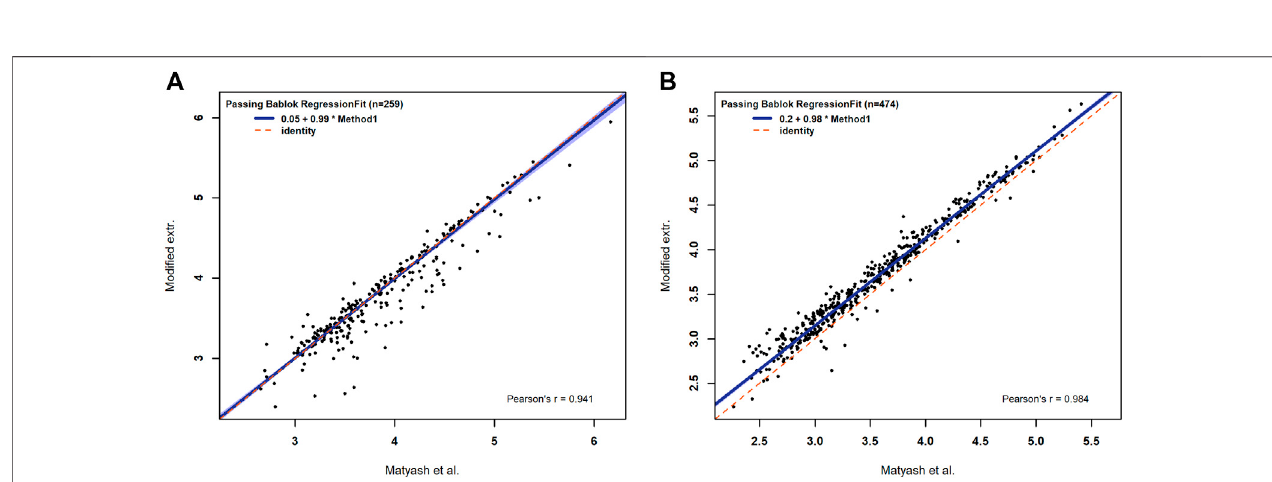
FIGURE2| Passing – Bablokregression fi tsforthelogarithmicintensitiesofidenti fi edlipidsinnegative (A) andinpositive (B) modes.Thedashedredlinerepresents the half line with a slope of one and in blue is the the con fi dence band of the Passing and Bablok regression with an α of 0.05.